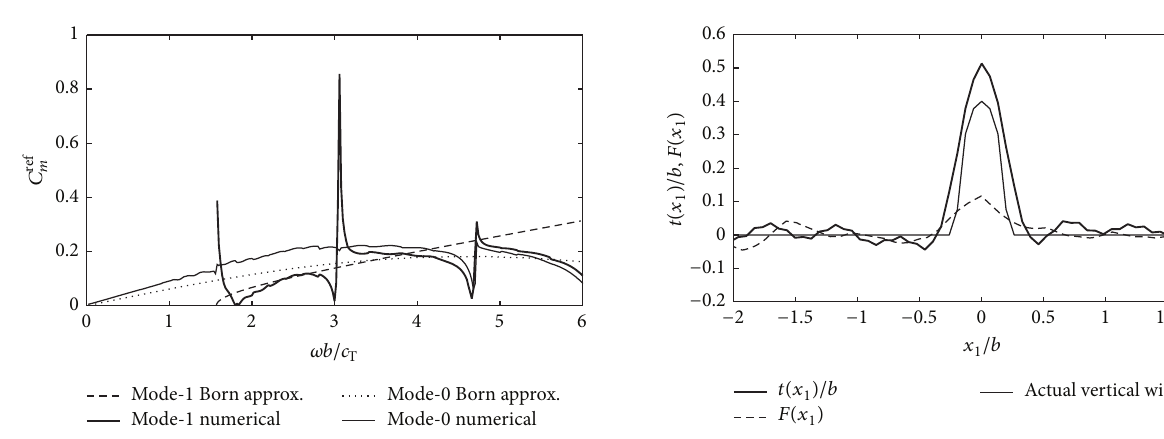
Figure 2: Reflection coefficients for 𝑅 1 = 𝑅 2 = 0.2𝑏 , ̃𝑥 2 = −0.5𝑏 . Figure 3: Reconstructed 𝑡(𝑥 1 ) and 𝐹(𝑥 1 ) for 𝑅 1 = 𝑅 2 = 0.2𝑏 , ̃𝑥 2 = −0.5𝑏